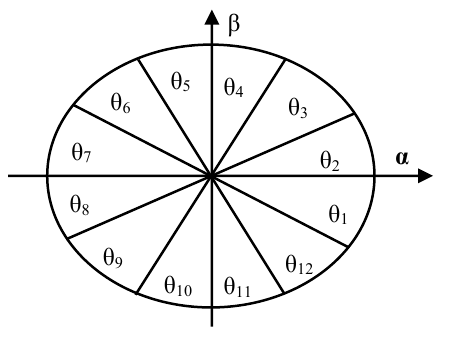
Figure 2. (α, β) sectors